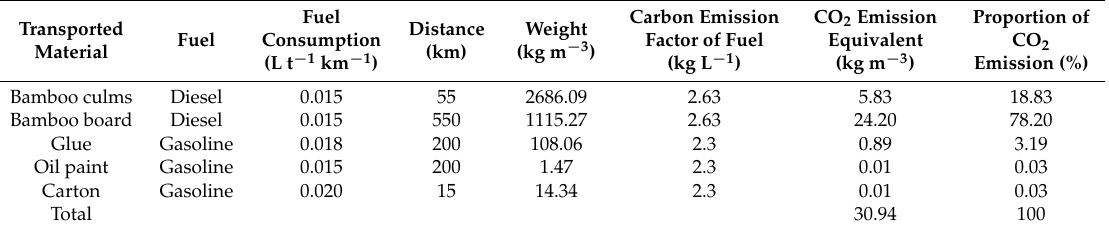
Table 1. Carbon emissions from transportation in producing one cubic meter of bamboo